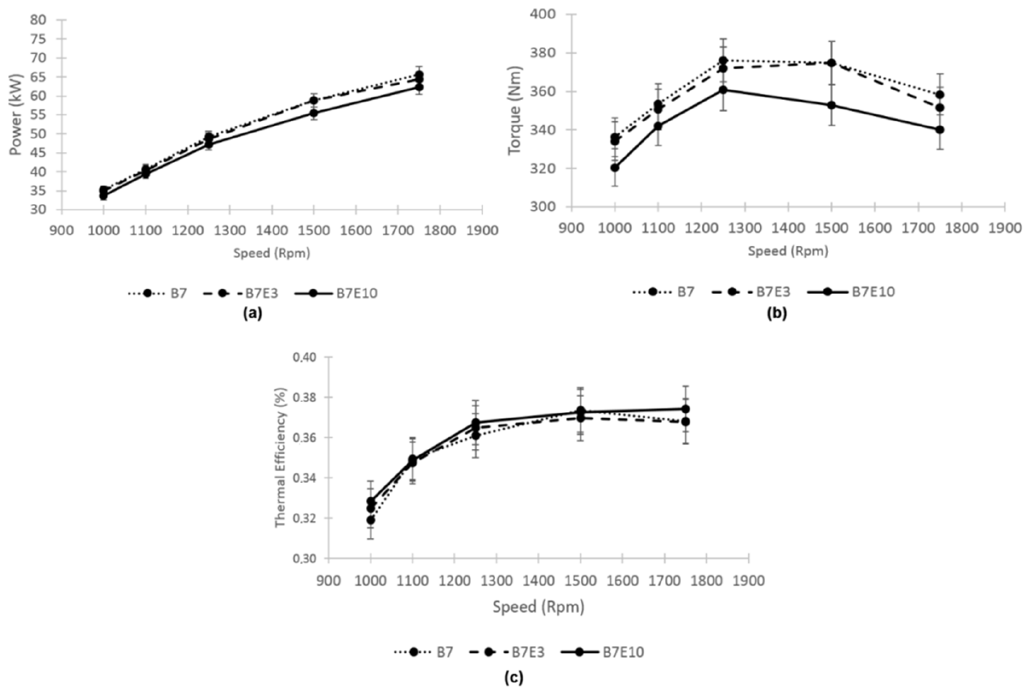
Figure 4. Diesel engine dynamometer performance results for each fuel blend: ( a ) power at 100% load for each speed; ( b ) torque at 100% load for each speed; and ( c ) thermal efficiency at 100% load for each speed.